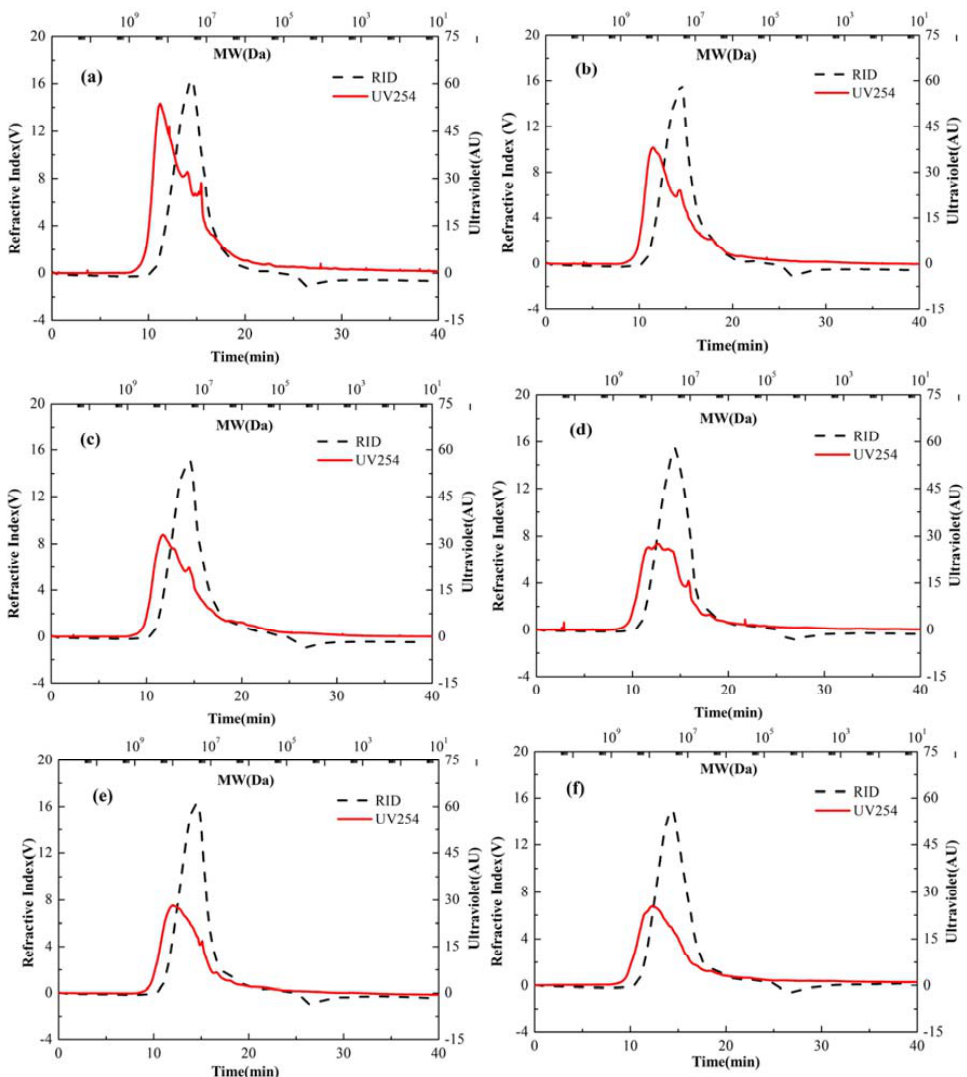
Figure 3. Molecular weight distribution of EPS at ozonation times of ( a ) 0 h; ( b ) 1 h; ( c ) 2 h; ( d ) 4 h; ( e ) 6 h; ( f ) 12 h.